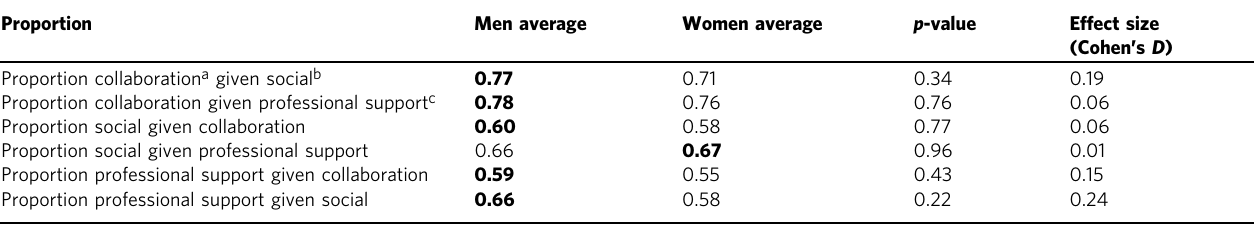
Table 3 Proportion of overlap between the social, collaboration, and professional support networks. Proportion